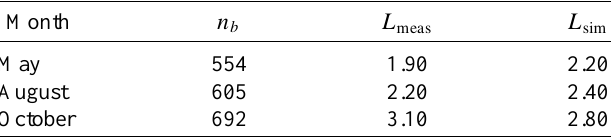
FIG. 4. (Color) Luminosity as a function of the beam current. The labels are the number of the colliding bunches. TABLE II. Luminosity comparisons for PEP-II.